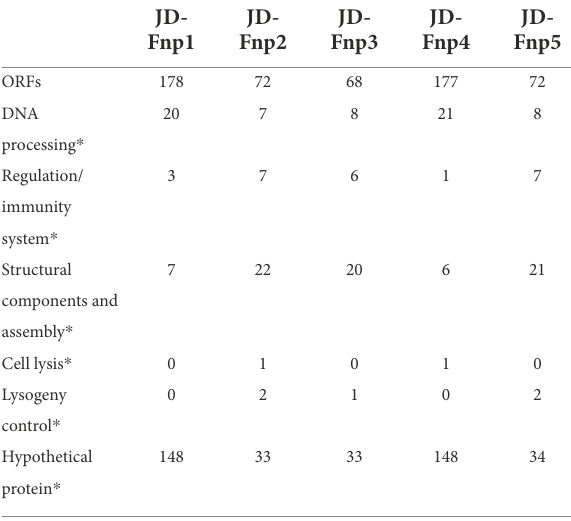
TABLE 3 ORFs annotation information of JD-Fnp1 ~ JD-Fnp5